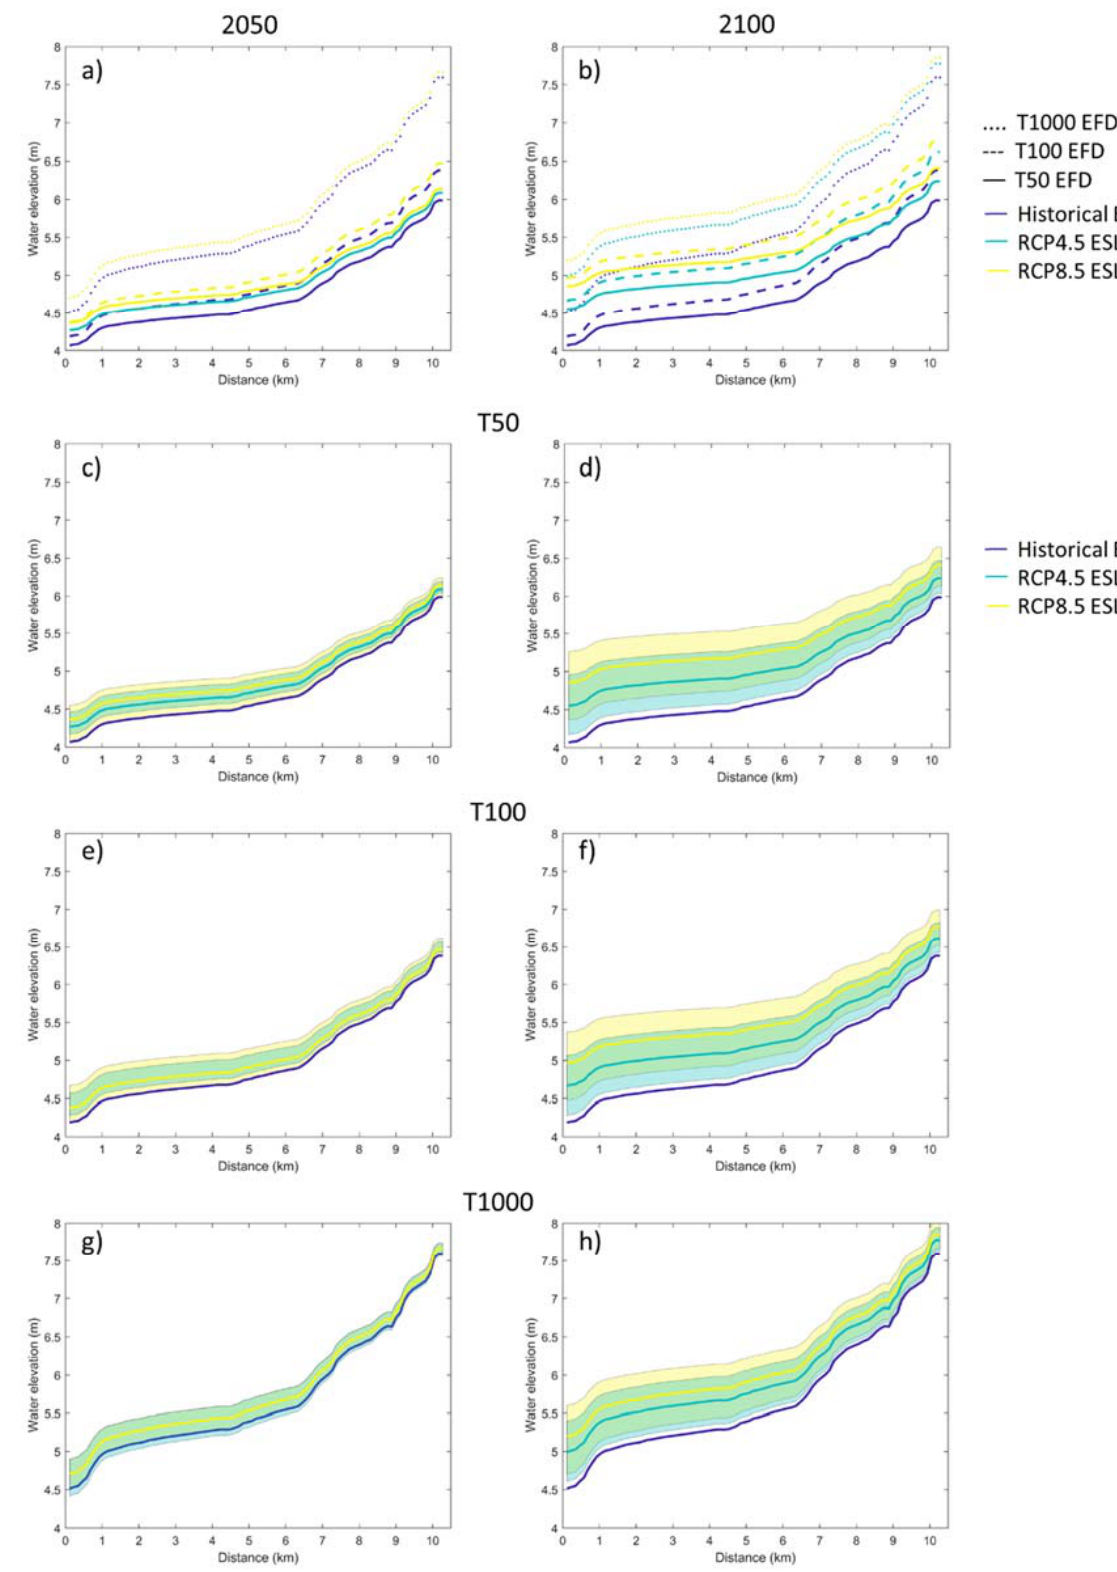
Figure 3. Longitudinal profiles of the superensemble solutions that represented the water level along the Minho estuary for the considered scenarios. ( a , b ) For average values of the water elevations at the ocean boundary; ( c – h ) Considering the maximum and minimum water elevations values at the ocean boundary to represent the probability forecast.